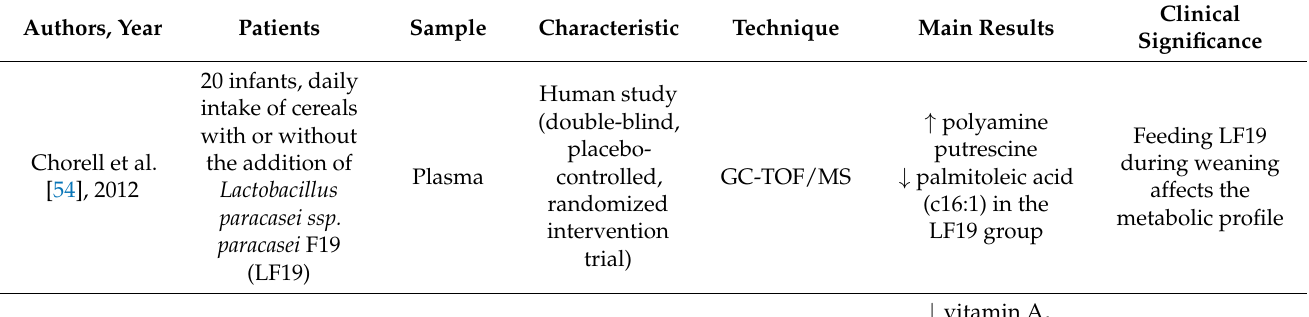
Table 2. Metabolomics studies in